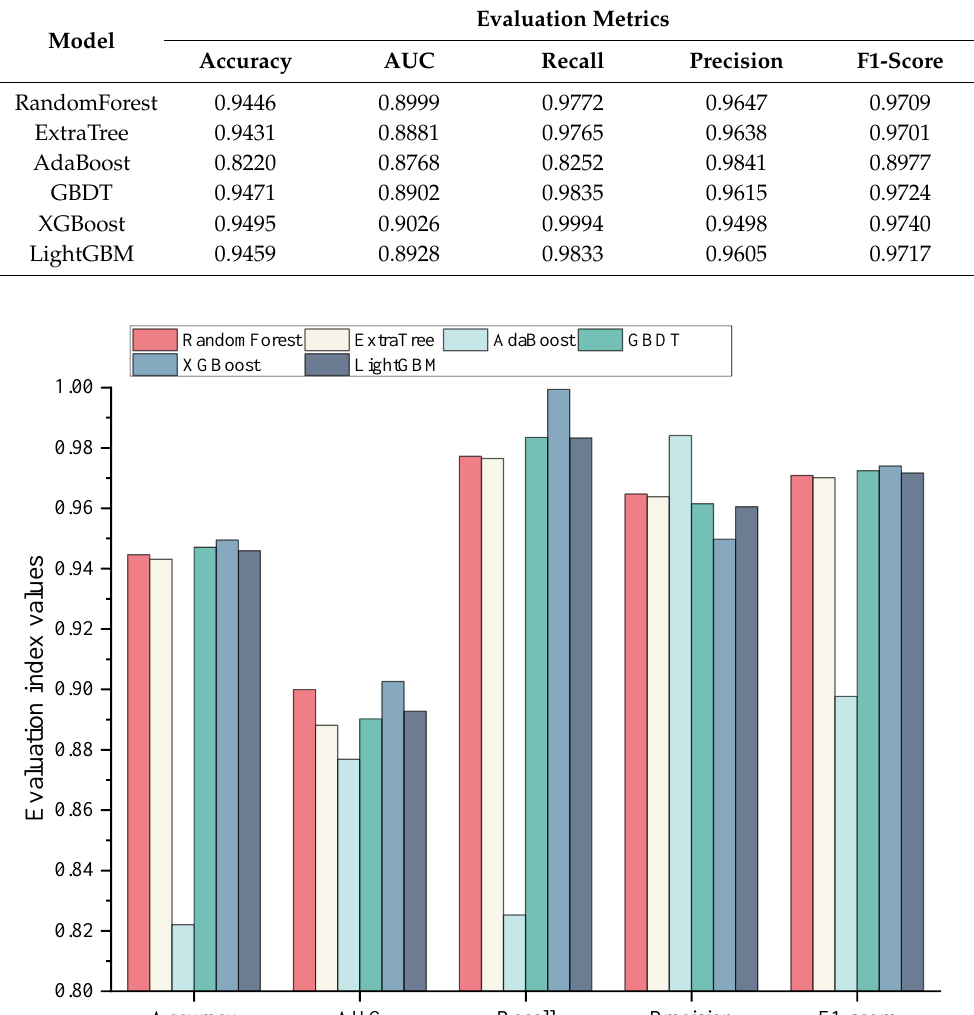
Table 11. XGBoost model versus traditional machine learning models.